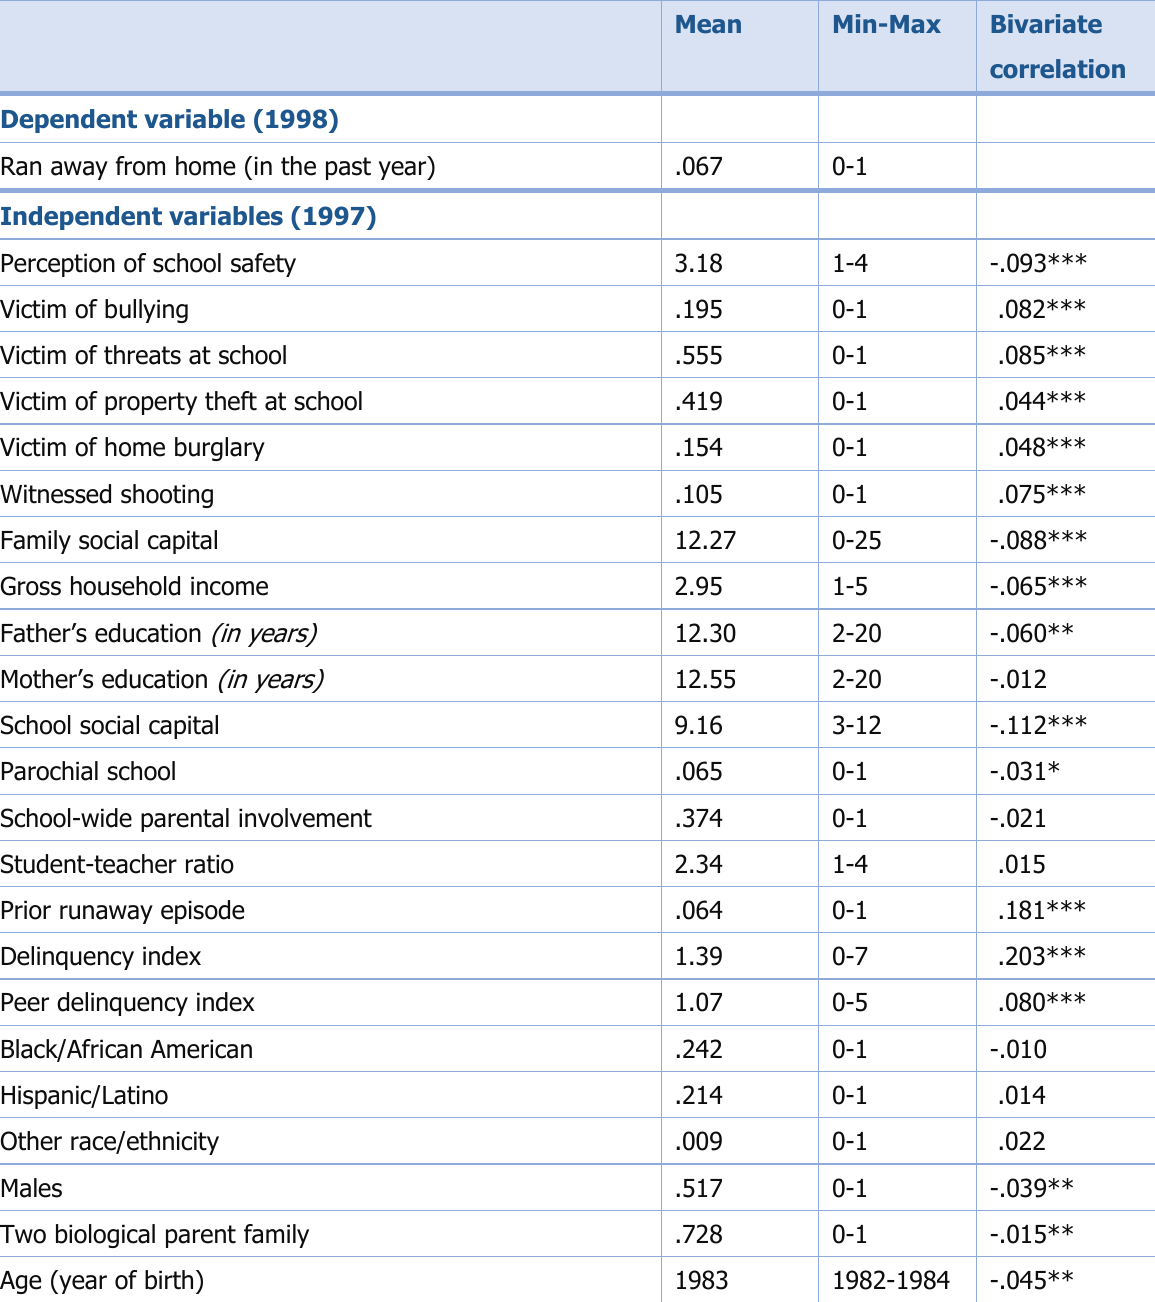
Table 1. Descriptive Statistics and Bivariate Correlations with Running Away From Home, N = 4,546